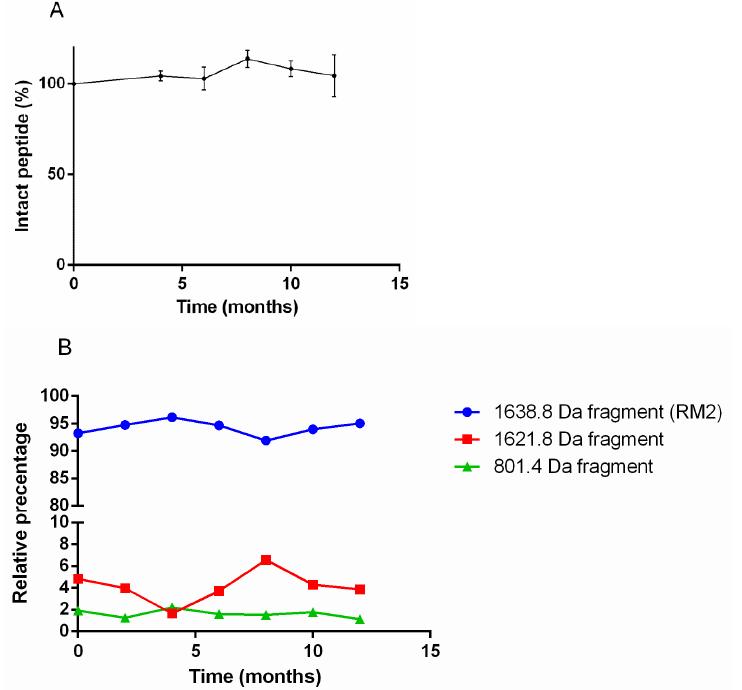
Figure 2. ( A ) UV-HPLC analysis of RM2 kit over time. Only one peak corresponding to intact RM2 was identified and remains stable over-time. ( B ) LC/MS/MS analysis of RM2 kit demonstrating the presence of intact RM2 and two fragments, the proportions of which remain constant over one year.